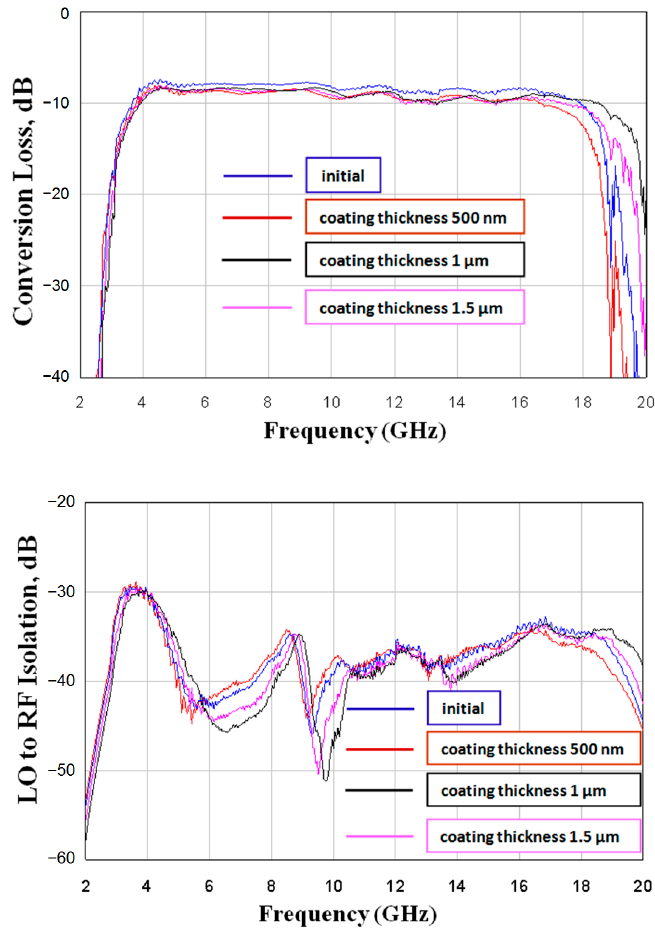
Figure 9. The main mixer parameters: conversion loss and LO to RF isolation.